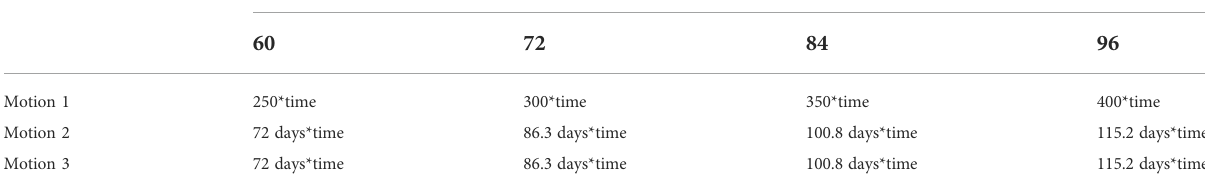
TABLE 5 Parametric equation under different planting frequencies. Motion Planting